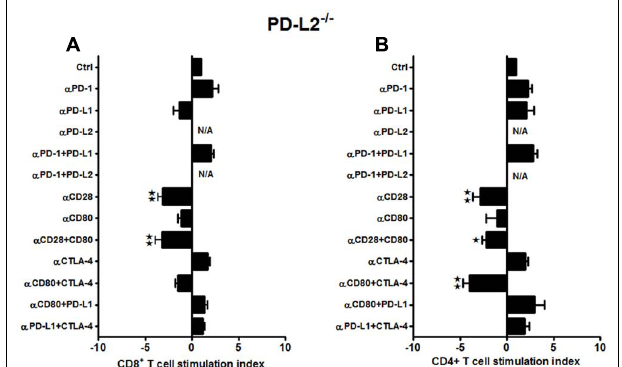
FIGURE 3 | Neutralizing the major co-stimulatory molecules in PD-L1 − / − mice, subjected to MCAO, leads to an increase in both CD8 + and CD4 + T-cell proliferative capacities, indicating an overall suppressive phenotype. T-cells were purified, by negative sort, from the spleens of MCAO-subjected PD-L1 − / − mice, by labeling with specific microbeads and separating on the AutoMACSTM TM .The purifiedT-cells were CSFE-labeled and then cultured with non-T-cells from the same mice at a 1:1 ratio (T:APC) in the presence of anti-CD3 antibody (2.5 μ g/mL; baseline) and other neutralizing Abs (10 μ g/mL) to co-stimulatory molecules, in 96-well plates. After 72 h of culture, cells were washed and evaluated by FACS Calibur for (A) CD8 + and (B) CD4 + T-cell expression and CFSE dilution. Data represent the stimulation indices of the CD8 and CD4 T-cells in the presence of neutralizing Abs as compared to the control [(T:APC + anti-CD3 Ab) condition].The data are represented such that the baseline value is 1 and all other values are adjusted relative to the baseline. Data presented are representative of splenocytes obtained from six PD-L1 − / − mice, with least three separate experiments and each experiment comprising duplicates or triplicates of the given neutralizing Ab condition. Significant differences between sample means are indicated as * p ≤ 0.05, ** p ≤ 0.01 and *** p ≤ 0.001 as compared to the baseline condition.